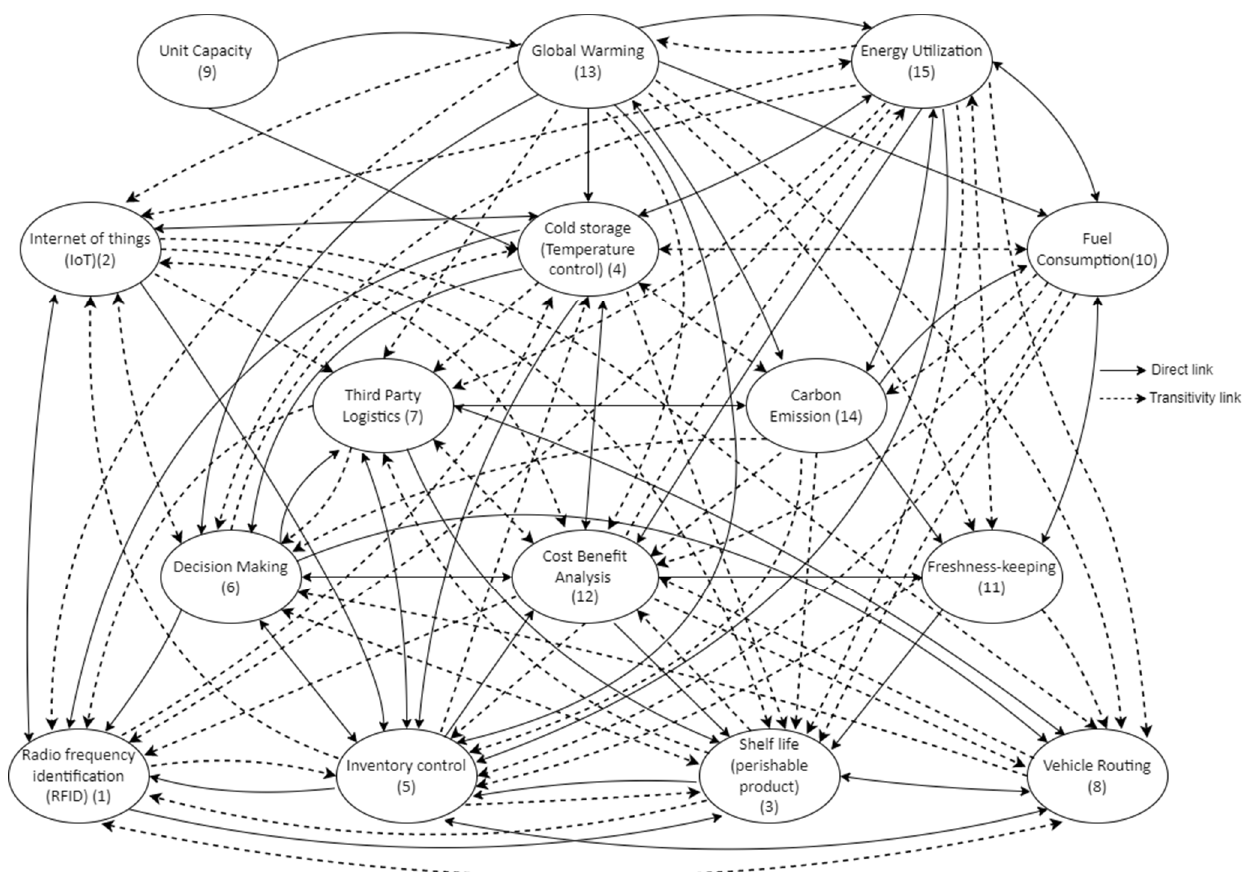
Figure 3. Diagraph of perishable food supply chain enablers.